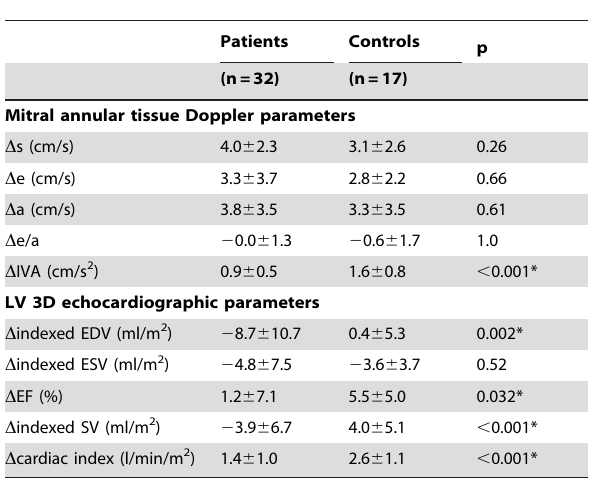
Table 4. Differences ( D ) between exercise and baseline echocardiographic parameters.